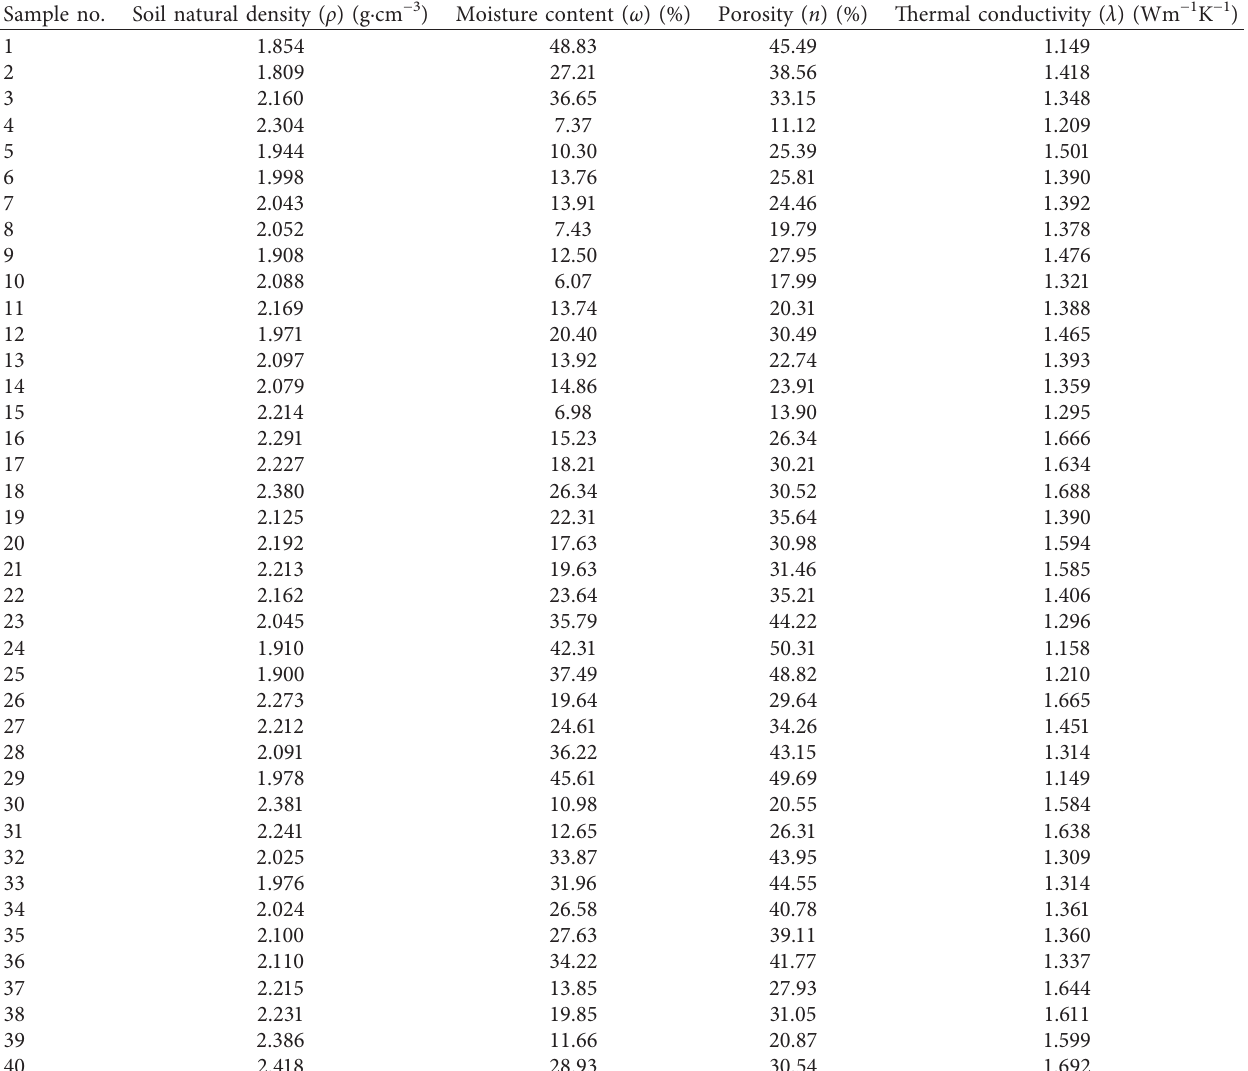
Table 1: Physical parameters of silt clay and thermal conductivity. Sample